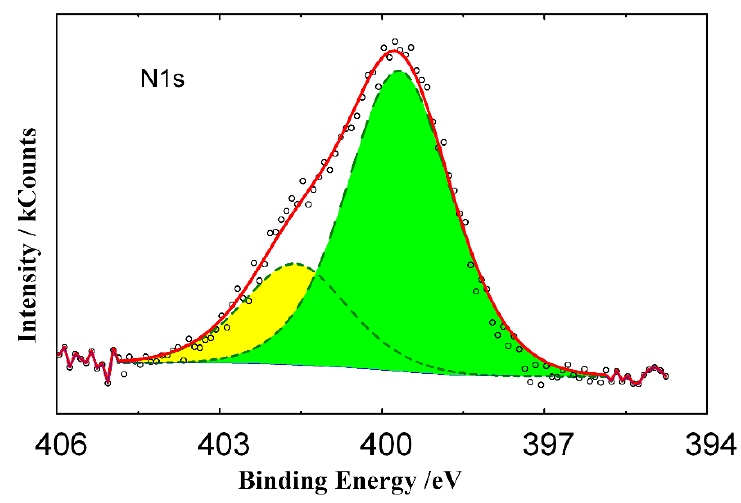
Figure 10. XPS spectra of O1s electrons on the steel surface after preliminary inhibitor adsorption (2.0 M HCl + 5.0 mmol TA, 25 °C, 24 h).